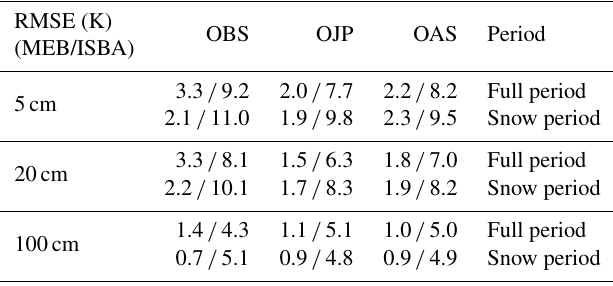
Table 7. BIAS for the ISBA-MEB and ISBA experiments for soil temperature at 5, 20, and 100cm calculated over half-hourly data. BIAS (K)